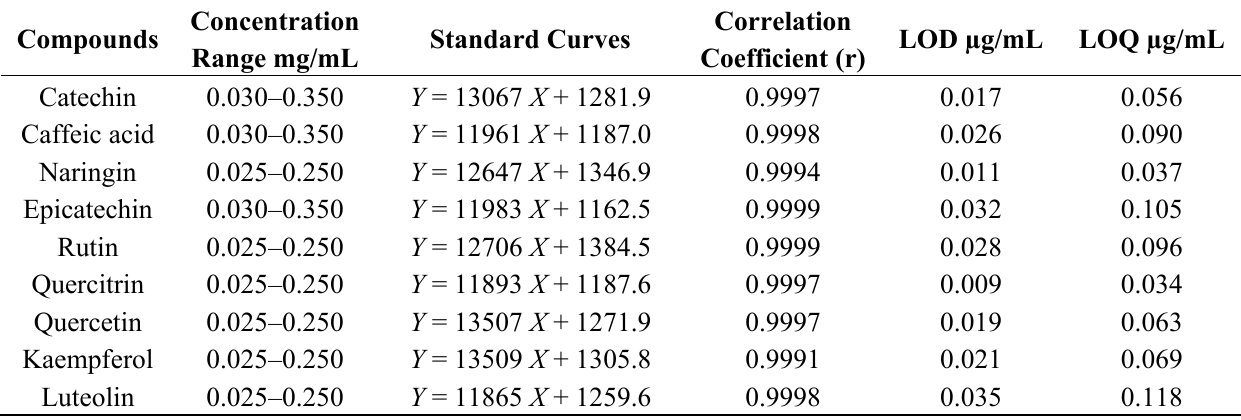
Figure 1. Representative high performance liquid chromatography profile of unripe orange peel powder ( A ) and ripe orange peel powder ( B ). Catechin (peak 1), caffeic acid (peak 2), naringin (peak 3), epicatechin (peak 4), rutin (peak 5), quercitrin (peak 6), quercetin (peak 7) kaempferol (peak 8) and luteolin (peak 9). Table 2. Chromatographic parameters of the method used for quantification of compounds in orange peel powder (ripe and unripe)